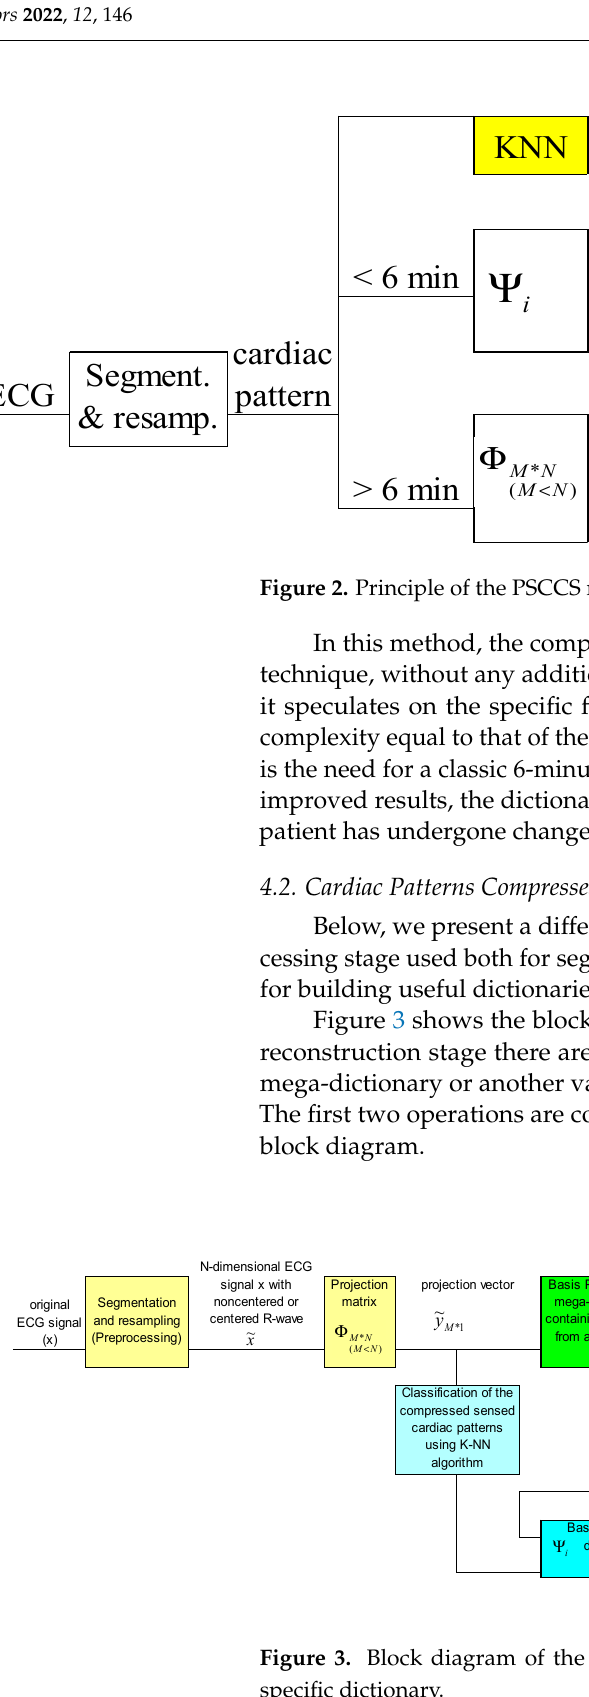
with dictionaries specific to